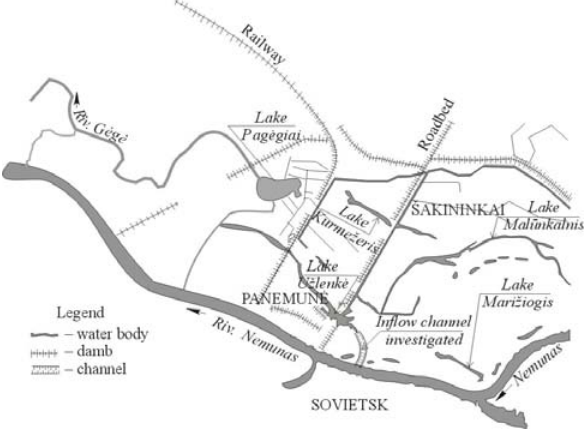
Fig. 1. Floodplain of Nemunas delta The way that road banks have been built across the floodplains generally causes the water discharge flowing trough the valley to decrease. Therefore, a trace design must be chosen that minimises this